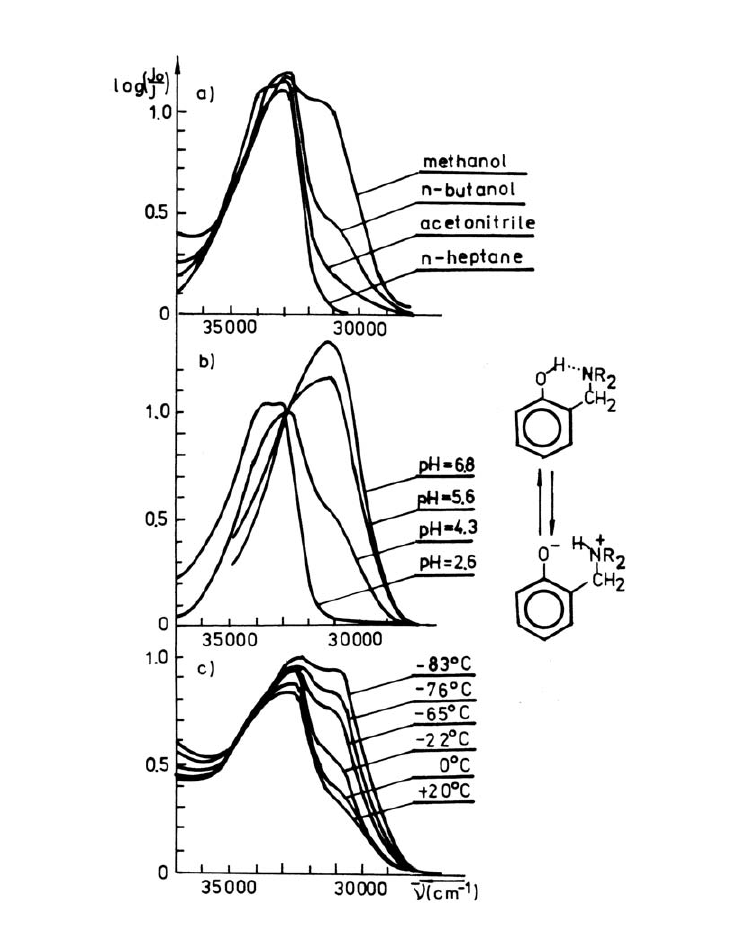
Figure 1. Spectroscopic manifestation of the intramolecular proton transfer and ionization of phenol group in 2-(pyperidinomethyl)-3,4,6-trichlor-phenol; a) solvent effect, b) pH effect, c) temperature effect